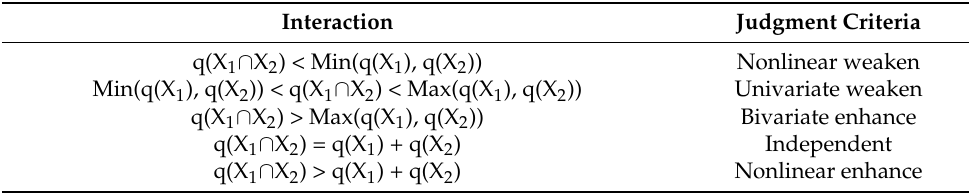
Table 1. Types of interactions between two factors. Interaction Judgment Criteria